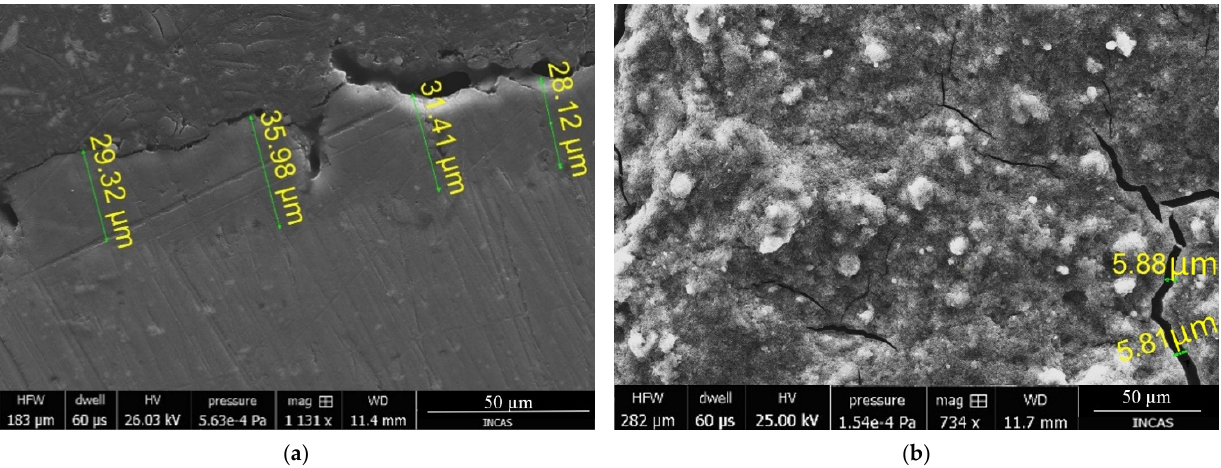
Figure 8. SEM micrographs of the layers’ surface deposited on corundum blasted substrate at different magnifications before testing: ( a ) surface view with a magnification of 109×; ( b ) surface view with a magnification of 336×.